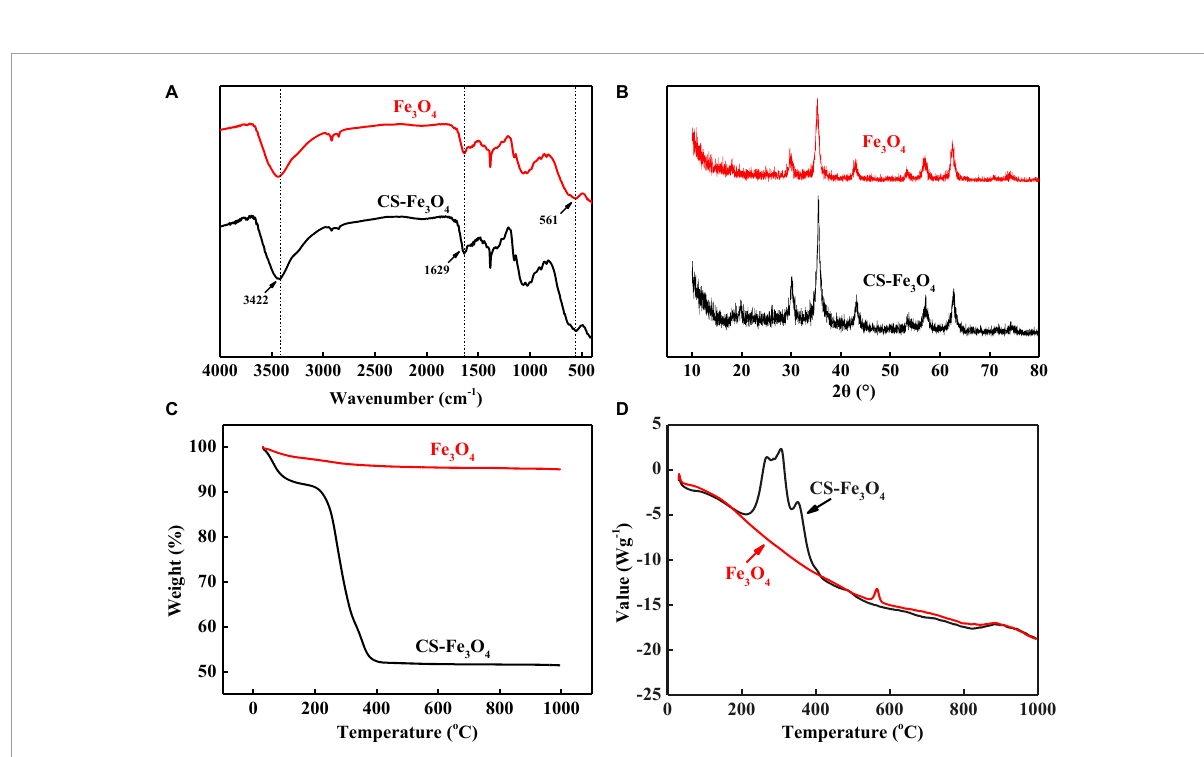
FIGURE2 (A) Fourier transform infrared (FT-IR) spectra. (B) High-resolution X-ray diffraction (XRD) spectra of C 1s signals. (C) Thermogravimetric analysis (TG) curves. (D) Differential scanning calorimetry (DSC) curves of CS-Fe 3 O 4